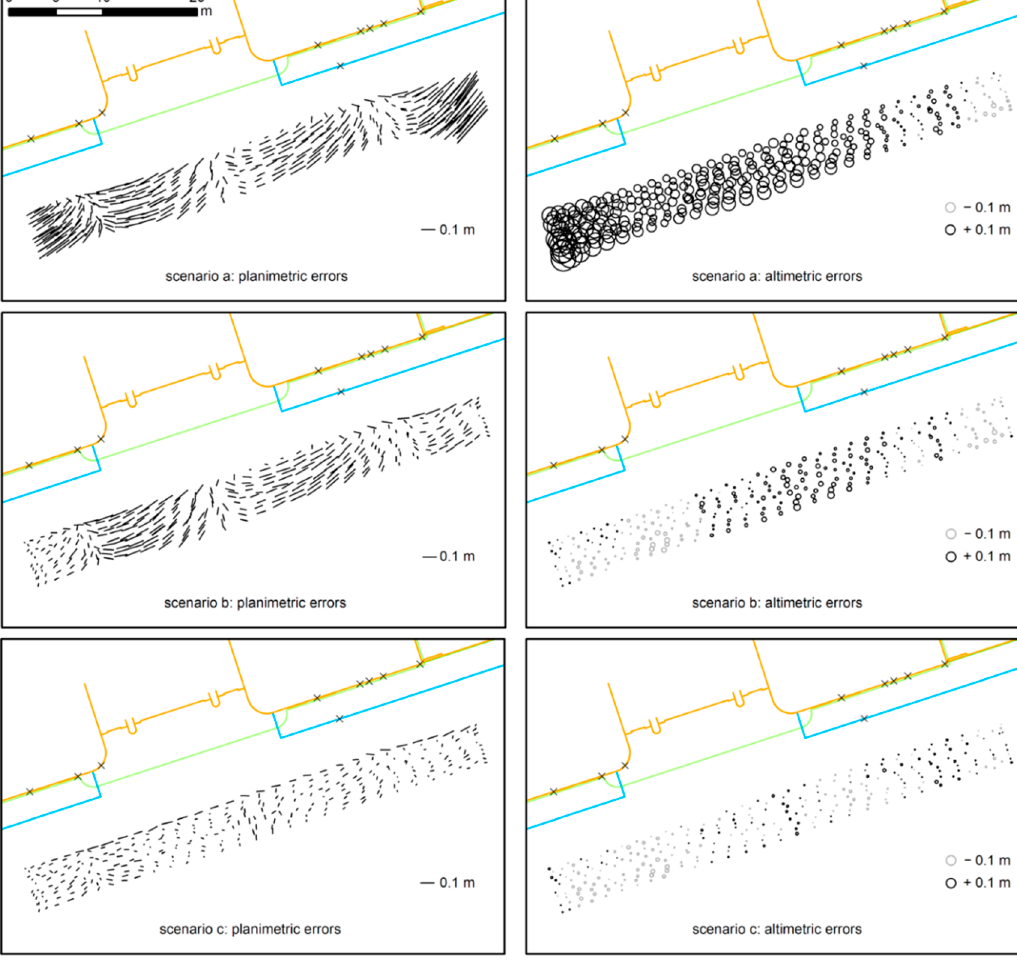
Figure 6. Planimetric and altimetric differences between the photogrammetric and the GPS solutions for the different scenarios. In the upper part the (true) plan of the buildings, the gate (orange), the roofing (green) and the sidewalk (blue) are visible. GCPs are represented by crosses.